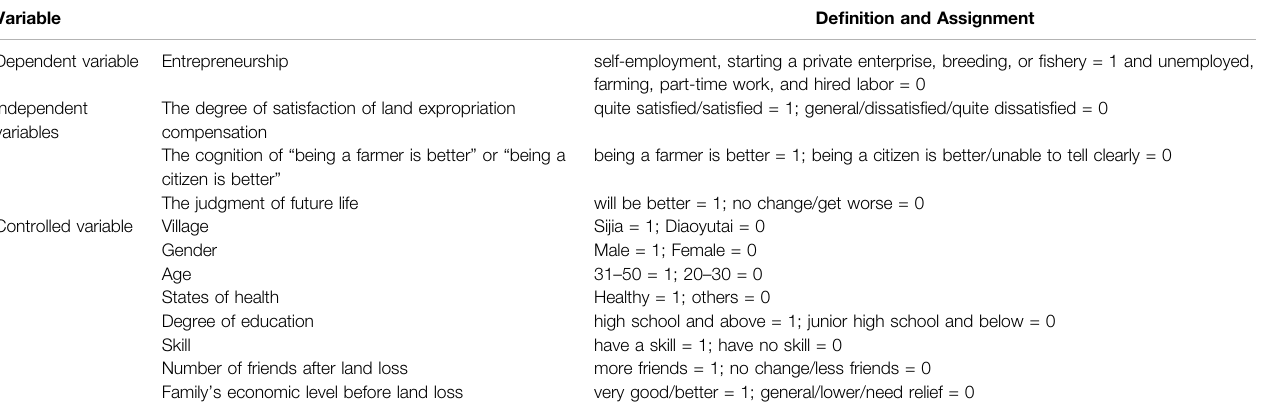
TABLE 1 | De fi nitions and assignment of independent and dependent variables. Variable De fi nition and Assignment Dependent variable